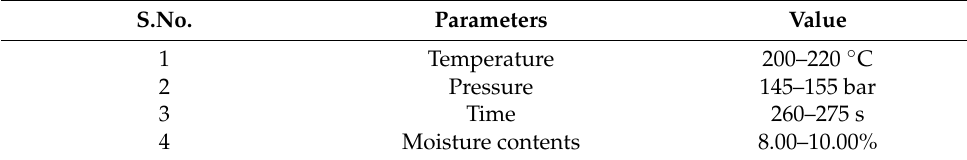
Table 1. Process parameters for hot pressing.